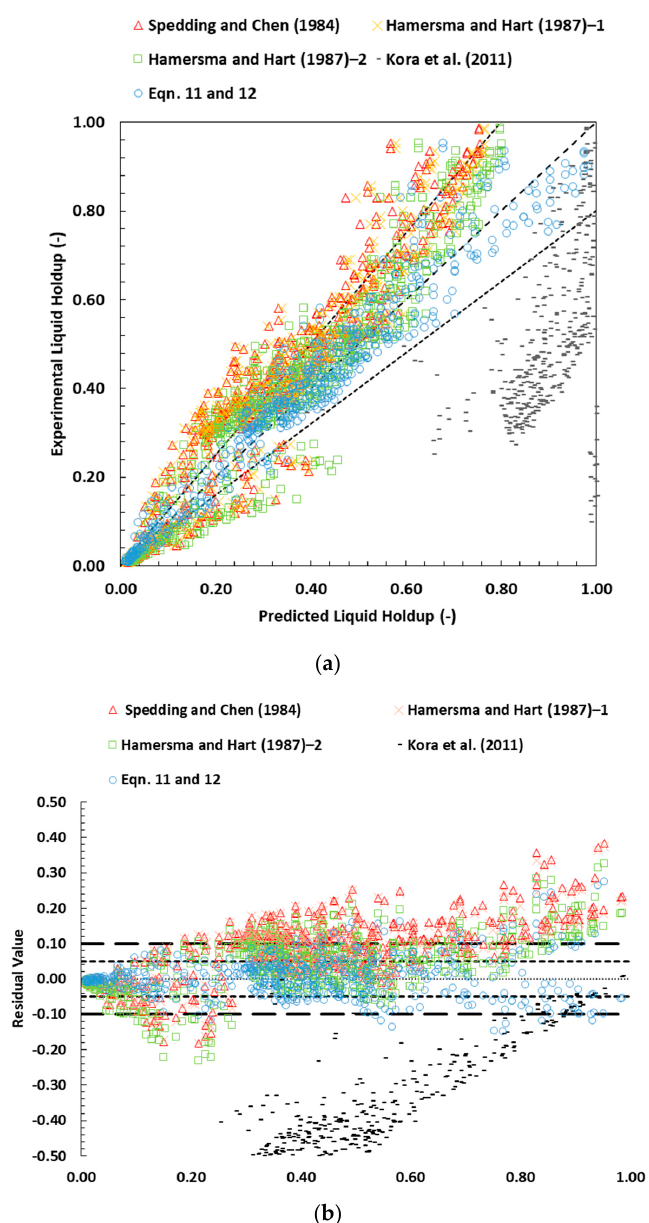
Figure 11. ( a ) the predicted values from Equations (11) and (12) against the correlations available in the literature and ( b ) Residuals of the predicted ε (L) -( y -axis) vs. ε (L) -( x -axis) using Equations (11) and (12) and the correlations available in the literature.